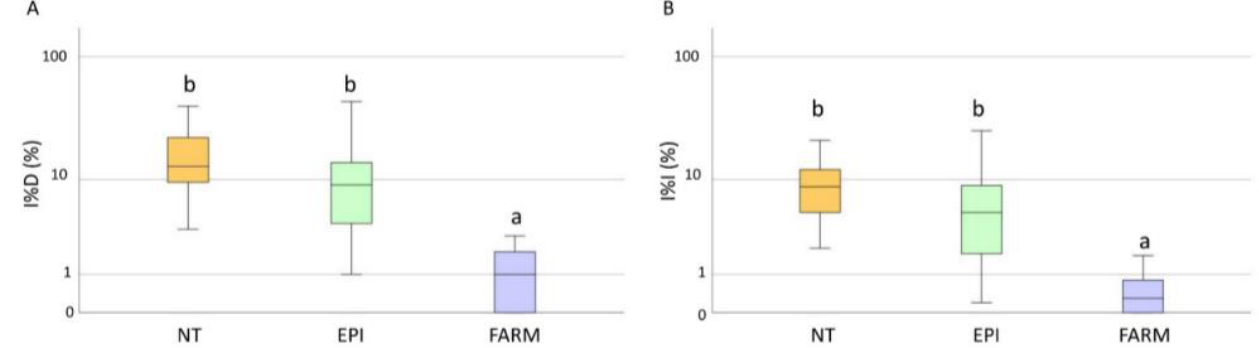
Figure 5. Box plot distribution of the final powdery mildew disease incidence (I%D) ( A ) and severity (I%I) ( B ) registered in 2020 on bunches in the untreated (NT), EPI (EPI), and farmers’ strategy (FARM) plots. Different letters indicate significant differences among samples ( p < 0.05).